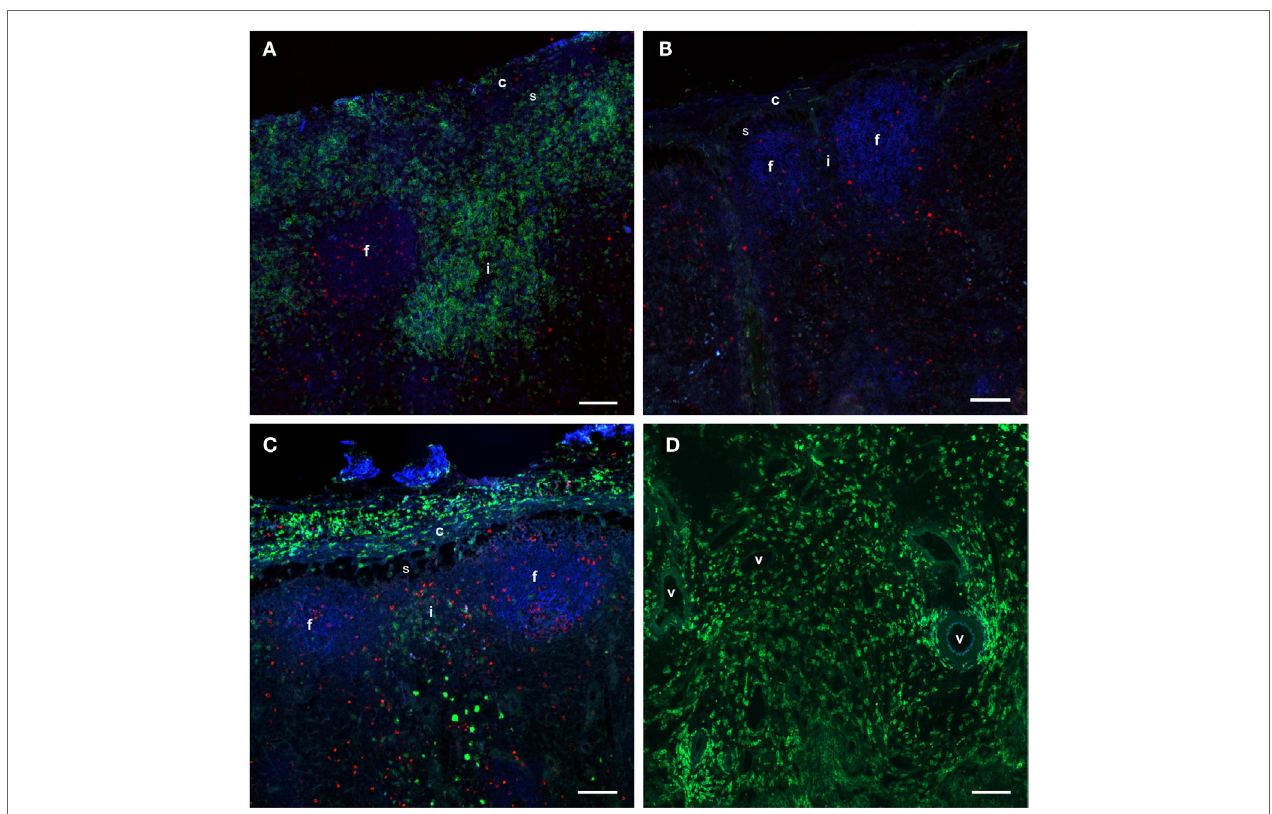
FigUre 5 | Distribution of monocytes in the lns . Immunofluorescent labeling of LNs with antibodies against CD14 (green), CD21 (blue), and Ki67 (red). CD21 stains the LN follicles. (a) CD14 + cells were present in the capsule, subcapsular sinus, peri-trabecular sinus, and interfollicular areas of the draining LN at 24 h post-injection. (B) The contralateral LN was mainly devoid of CD14 + cells. Note the empty sub capsular sinus and trabecular sinus areas, as opposed to the infiltration in (a) . (c) CD14 + cells were abundant in the capsule, but were decreased in numbers in the sinus and the cortex at 48 h post-injection. (D) CD14 + cells were present in the medulla of the LN at 48 h post-injection, and particularly around vessels. Follicle (f), interfollicular area (i), capsule (c), sinus area (s), vessel (v). Scale bars: 100 μ